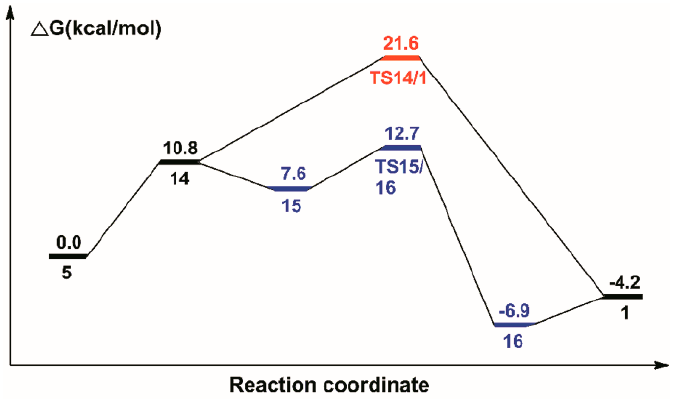
Figure 9. Free energy profile for the regeneration of the catalyst.